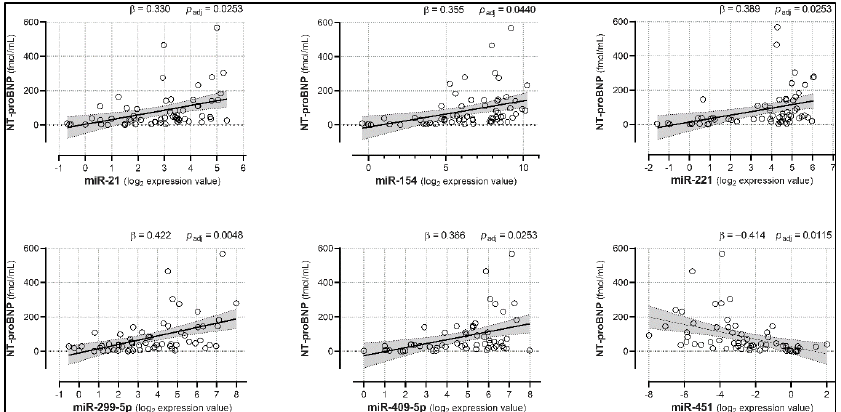
Figure 3. Circulating miRNAs associated with NT-proBNP plasma concentration. Five miRNAs showed positive associations, whereas one miRNA was negatively associated with NT-proBNP levels. Analyses were adjusted for age, sex, diabetes mellitus, hypertension, hypercholesterolemia, and smoking habit. Trendlines are depicted along with the 95% confidence interval (light gray). p adj = p -values corrected for multiple testing; n = 61. Biomedicines 2020 , 8 , 597 Table 2. Associations between microRNAs and NT-proBNP concentration.